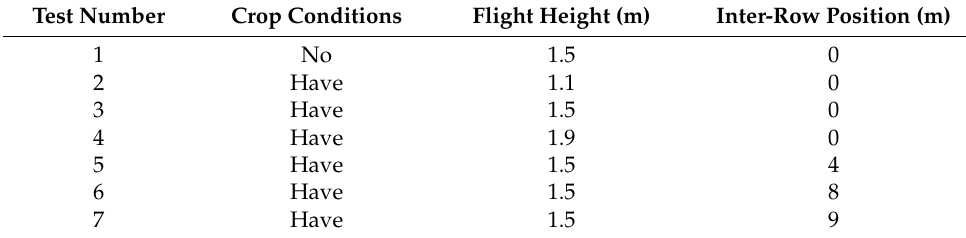
Table 4. Number of rotor